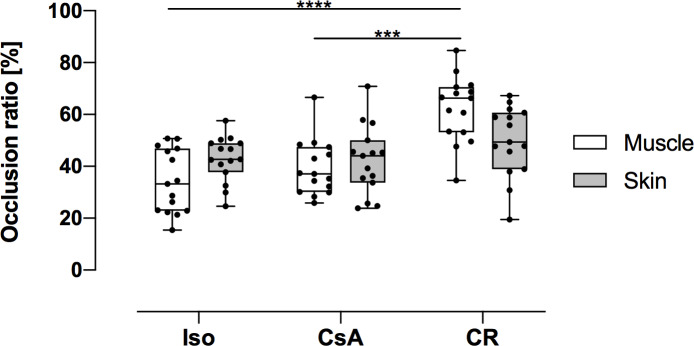
Arterioles occlusion ratios in muscle and skin at POD 100.Data is presented as individual data points and boxplots; boxplots show the median, 25%- and 75%-quartile; whiskers indicate the minimum and maximum. CR group arterioles in muscle tissue demonstrated a significantly higher occlusion ratio in comparison to Iso and CsA groups (***: p < 0.001; ****: p < 0.0001).